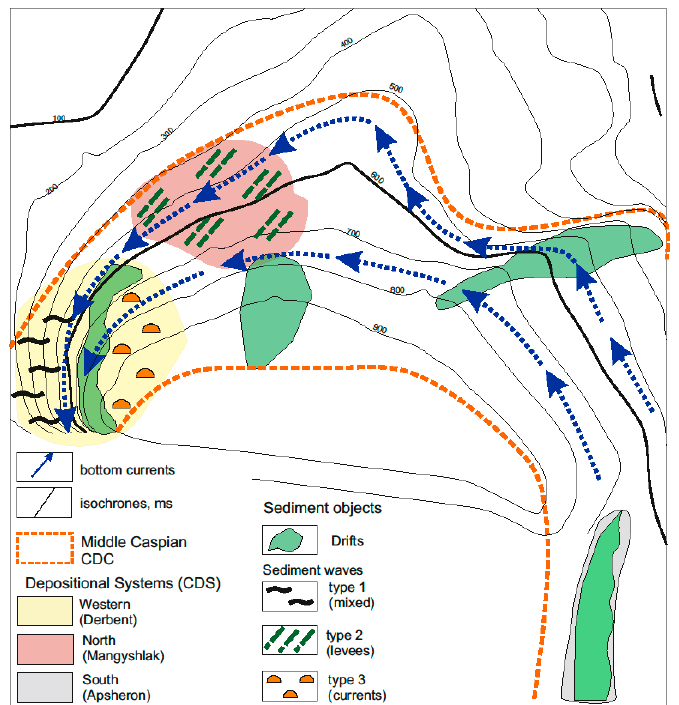
Figure 17. Contourite deposits (sediment waves and contourite drifts), contourite depositional complex (CDC) and contourite depositional systems (CDS) in the Middle Caspian Sea. Arrows show large circumcaspian current (Modified from